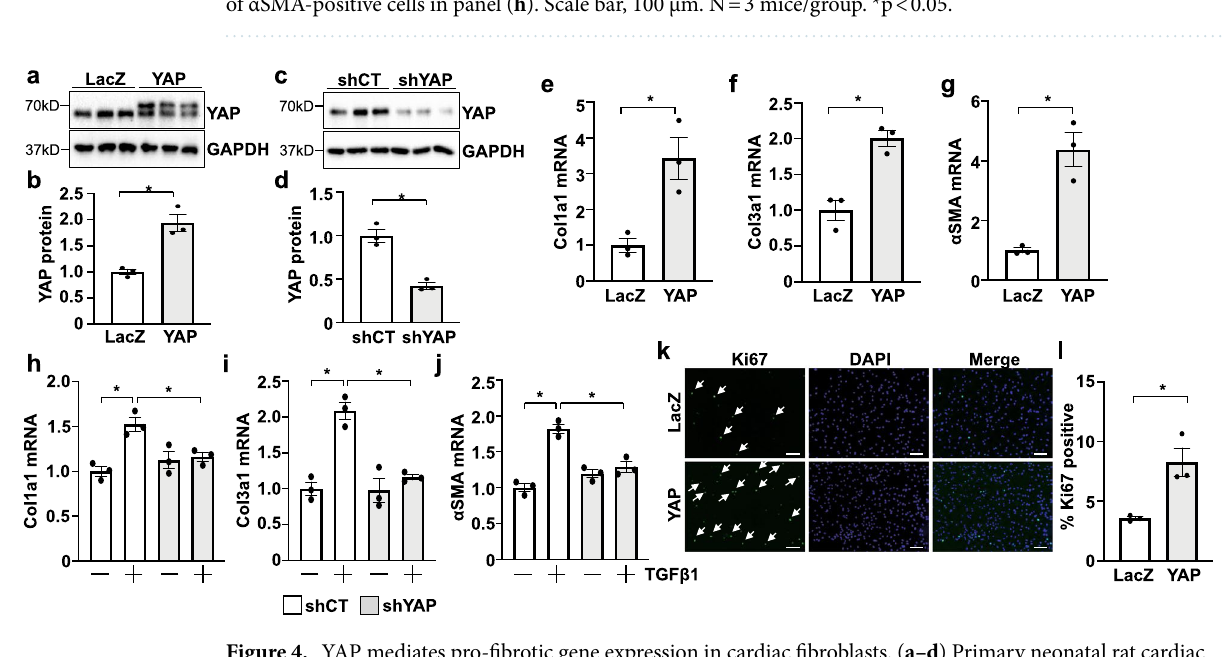
Figure 4. YAP mediates pro-fibrotic gene expression in cardiac fibroblasts. ( a–d ) Primary neonatal rat cardiac fibroblasts (NRCF) were subjected to adenoviral-mediated YAP overexpression or knockdown. Representative blots and quantification are shown. ( e–g ) YAP increased fibrosis-associated gene expression compared to LacZ control. ( h–j ) Depletion of endogenous YAP attenuated TGFβ1-induced expression of fibrosis-related genes. ( k , l ) YAP expression in NRCFs increased Ki67-positive nuclei compared to LacZ. White arrows indicate Ki67- positive nuclei. Scale bar, 100 μm. N = 3 experimental replicates. *p < 0.05. Full-length blots are presented in Supplementary Fig.